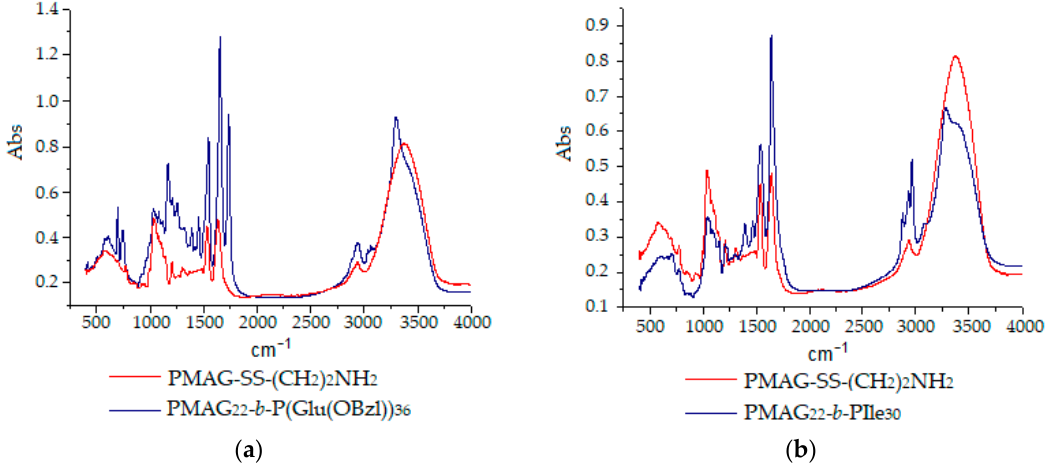
Figure 6. IR-spectra of homopolymer PMAG-NH 2 and PMAG- b -P(amino acid) block-copolymers: PMAG- b -PGlu(OBzl) ( a ) and PMAG- b -PIle ( b ).